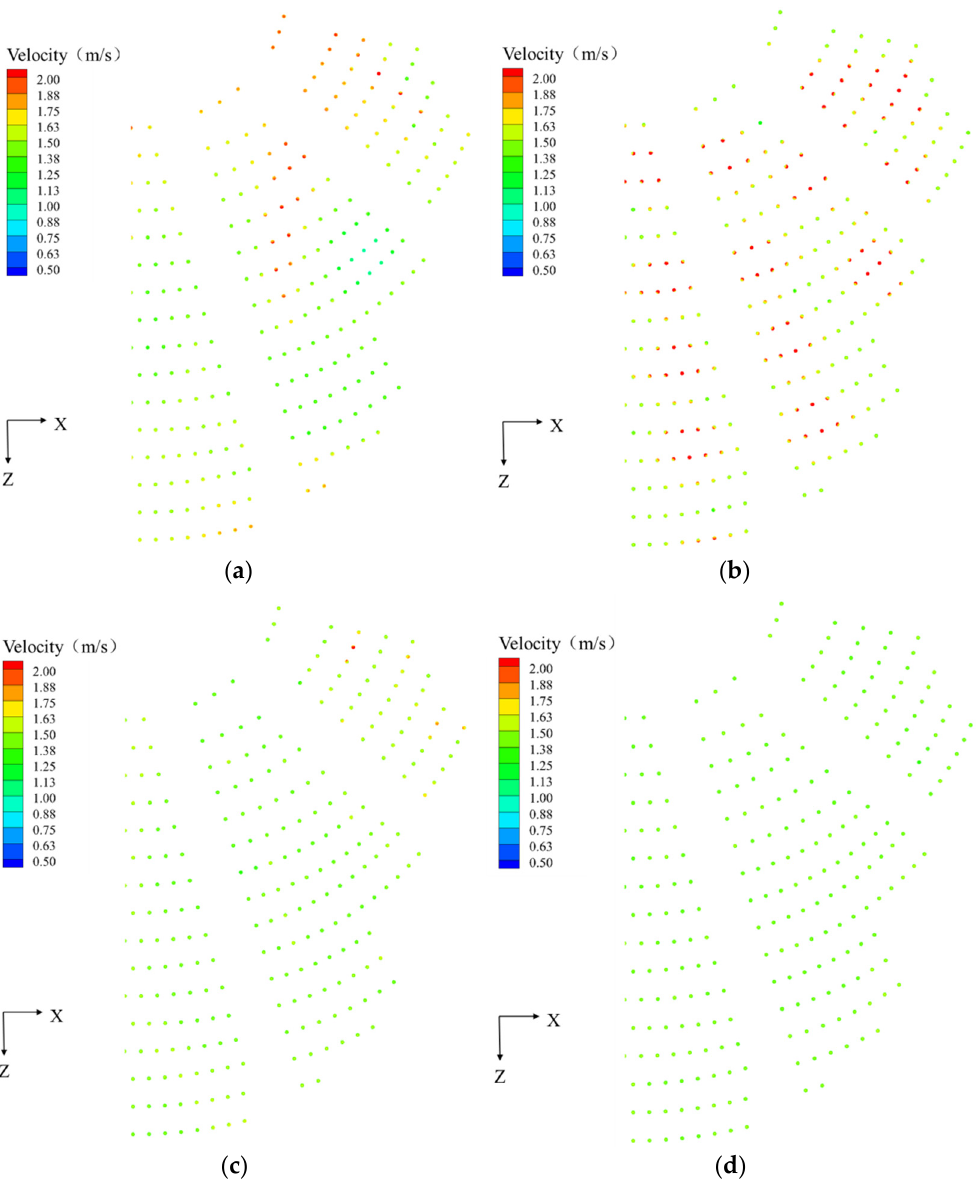
Figure 13. Outflow velocity contours of swirl diffusers. ( a ) case A, ( b ) case B, ( c ) case C, ( d ) case D.